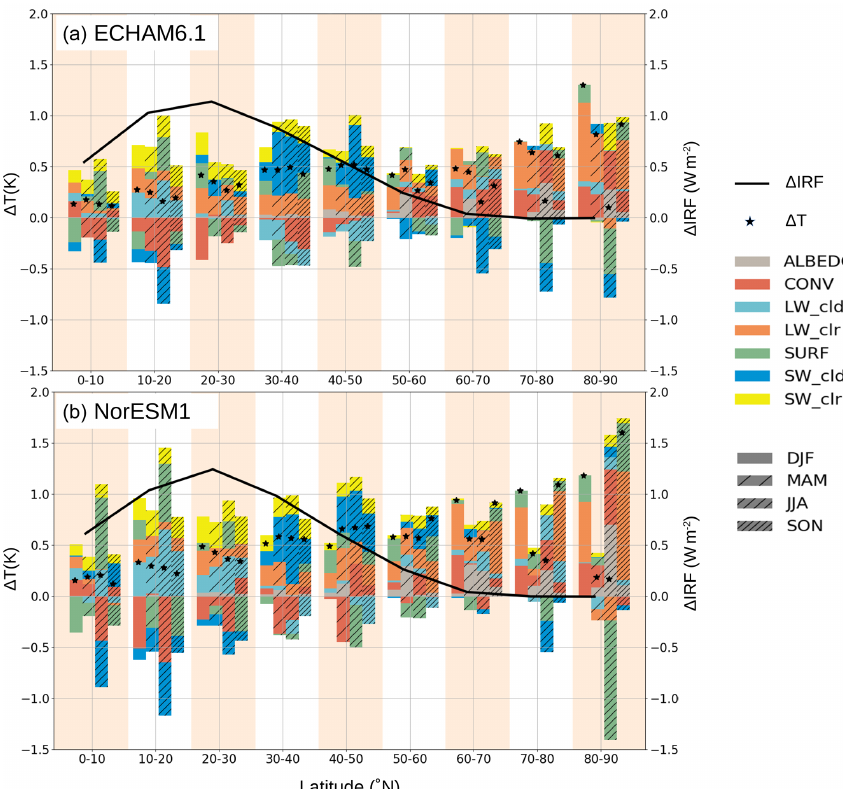
Figure 4. Seasonal cycles of surface temperature responses averaged over the northern-hemispheric latitude bands for the ECHAM6.1 (a) and NorESM1 (b) models. Color bars show the different contributions to seasonal mean temperature responses shown with the star symbols. Different seasons are indicated with different hatchings over the color bars. The solid lines indicate the change in the annual average Asian aerosol instantaneous radiative forcing ( (cid:49) IRF) for each model. The modest seasonality in radiative forcing is not shown for the sake of